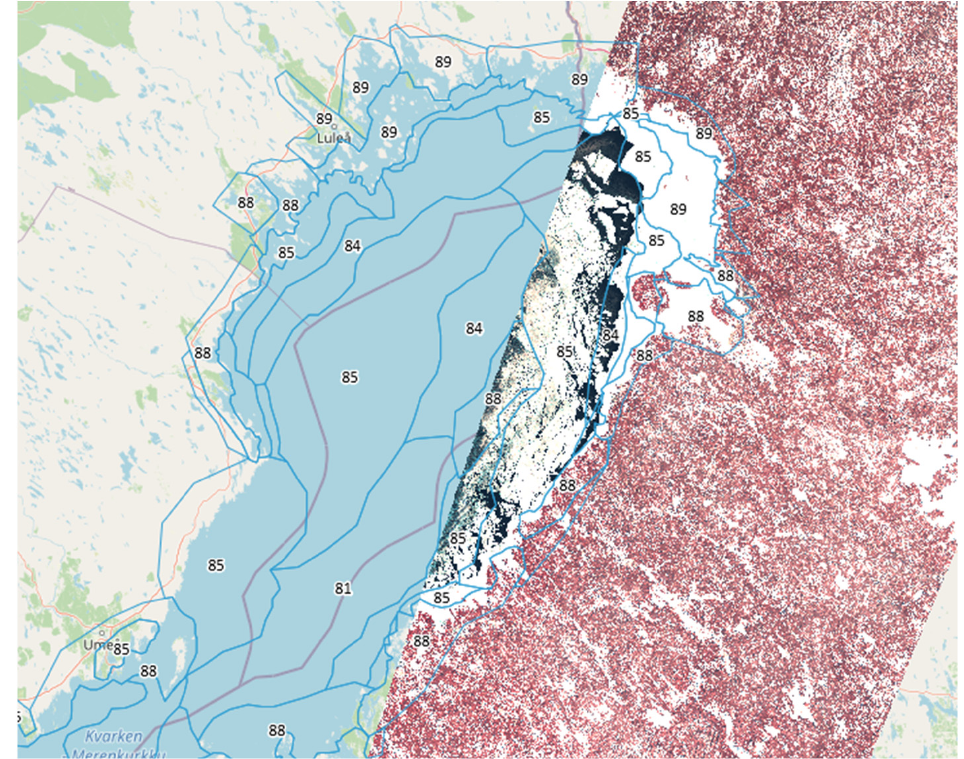
Figure 1. Landsat-8 false color image collection over the Baltic Sea at 2021-02-16; BSH Ice Chart for 2021-02-16 (blue polygons) with their ICESOD codes.